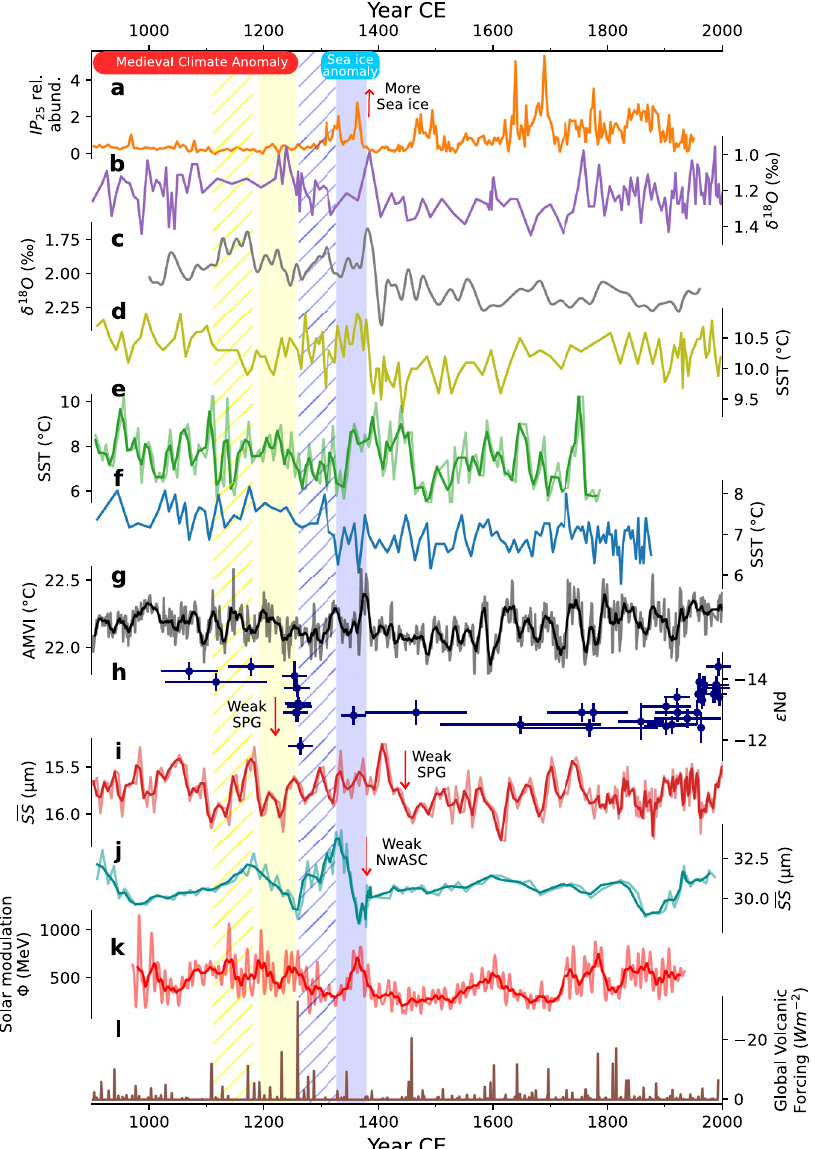
Fig.4 |Regionalenvironmentalreconstructionsspanning thelastmillennium. a AprilseaiceindexfromtheNorthIcelandicShelfbasedontherelativeabundance ofIP 25 ,abiomarkersynthesisedbysea-icediatoms 32 . b Oxygenisotoperecordfrom the planktonic foraminifera Neogloboquadrina pachyderma re fl ecting summer near-surface temperatures on the Norwegian margin 35 . c Oxygenisotope record as a proxy for SSTs on the Norwegian margin 36 . d August SST on the Eastern Norwe- gian Sea inferred from diatom assemblages 38 . e Annual SST in South Iceland based on paired Mg/Ca – δ 18 O measurements from the planktonic foraminifera Globor- otalia in fl ata 41 . f Summer SST in North Iceland based on diatom assemblages 39 . g Atlantic Multidecadal Variability Index (AMVI) reconstructed from Titanium content from a laminated sedimentary record from the Canadian Arctic 42 . h Neodymium isotopic composition ( ɛ Nd) in deep-sea corals from the north-